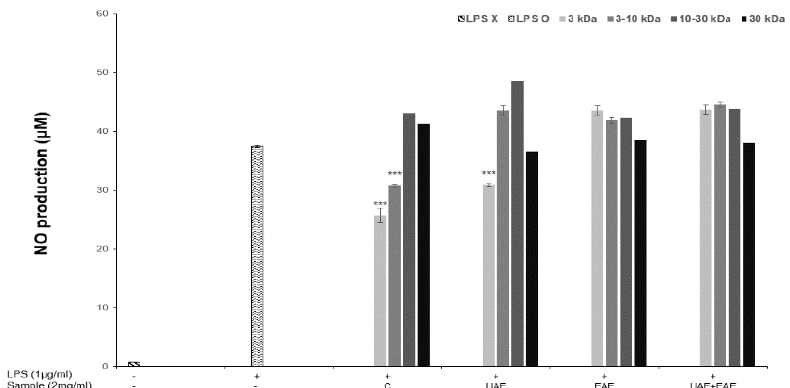
Figure 2. Inhibitory effect of collagen fractions extracted from APS on nitric oxide production in LPS-stimulated RAW 264.7 macrophage cells. C, control; UAE, ultrasound assisted extraction method; EAE, enzyme assisted extraction method; EAE+UAE, combination of enzyme and ultrasound assisted extraction methods. *** statistical significance of p <